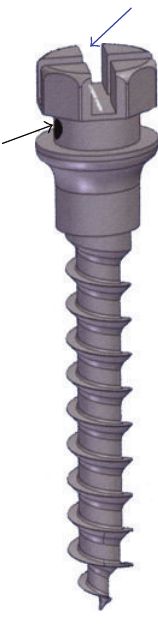
Figure 3: Dual-head miniscrew having rectangular slot and ligature hole. Hole used for threading ligature wire and securing MSPA in slot of bracketed head